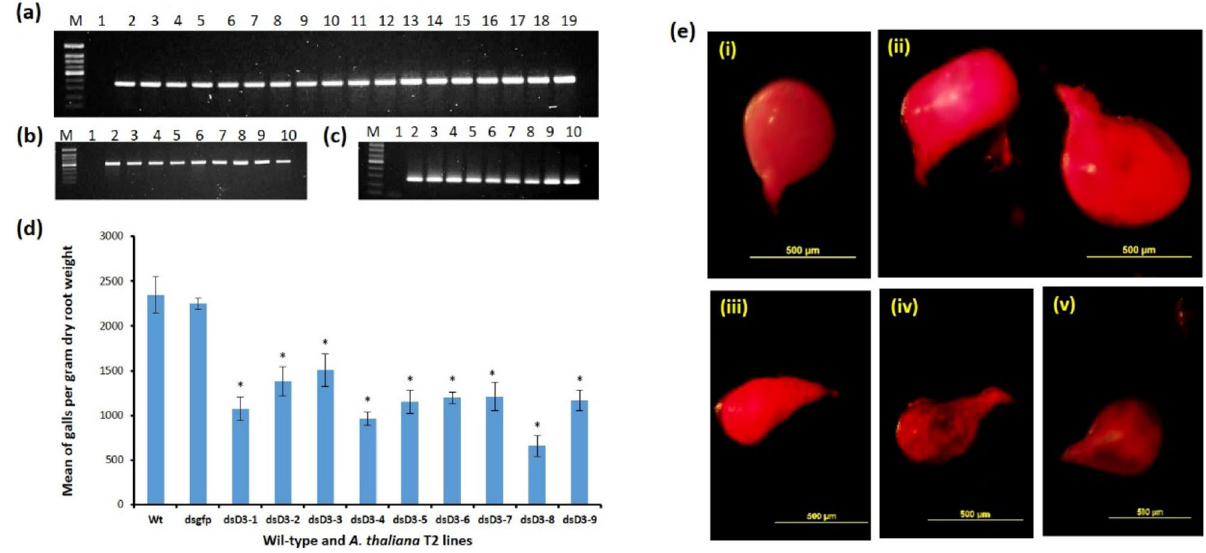
Figure 7. Characterisation of T2 transgenic A. thaliana lines. (a) PCR bands of the nptII gene (364 bp) from genomic DNA of transgenic lines. Lane M = 100 bp DNA marker, Lane 1 = No DNA control, Lane 2 – 10 = Bands from nine lines of dsgfp T2 plants, Lane 11–19 = Bands from nine lines of dsD3 T2 plants (b) RT-PCR of dsgfp hairpin from RNA of the nine T2 dsgfp lines. Lane M = 100 bp DNA marker, Lane 1 = No cDNA control, Lane 2–10 = Bands (524 bp) from cDNA of dsgfp from nine dsgfp lines. (c) RT-PCR of dsD3 hairpin from RNA of the nine T2 dsD3 lines. Lane M = 100 bp DNA marker, Lane 1 = no cDNA control, Lane 2–10 = Bands (251 bp) from cDNA of dsD3 from nine dsD3 lines. (d) Mean plus standard errors of the number of galls per gram of dry root weight on T2 Arabidopsis lines carrying hairpins of dsgfp, and nine lines of dsD3 (Dcr1-1 to Dcr1-9). Means significantly different from that of controls at p < 0.05 ascertained by using T-test (two-tailed) based on 14 replicates for each transgenic line and 20 replicates for wild-type plants. (e) Acid-fuchsin-stained representative adult M. incognita females dissected from infected wild-type and T2 transgenic lines carrying hairpins of dsgfp and dsD3. Females dissected out of (i) wild-type plants (ii) dsgfp plants (iii,v) dsD3